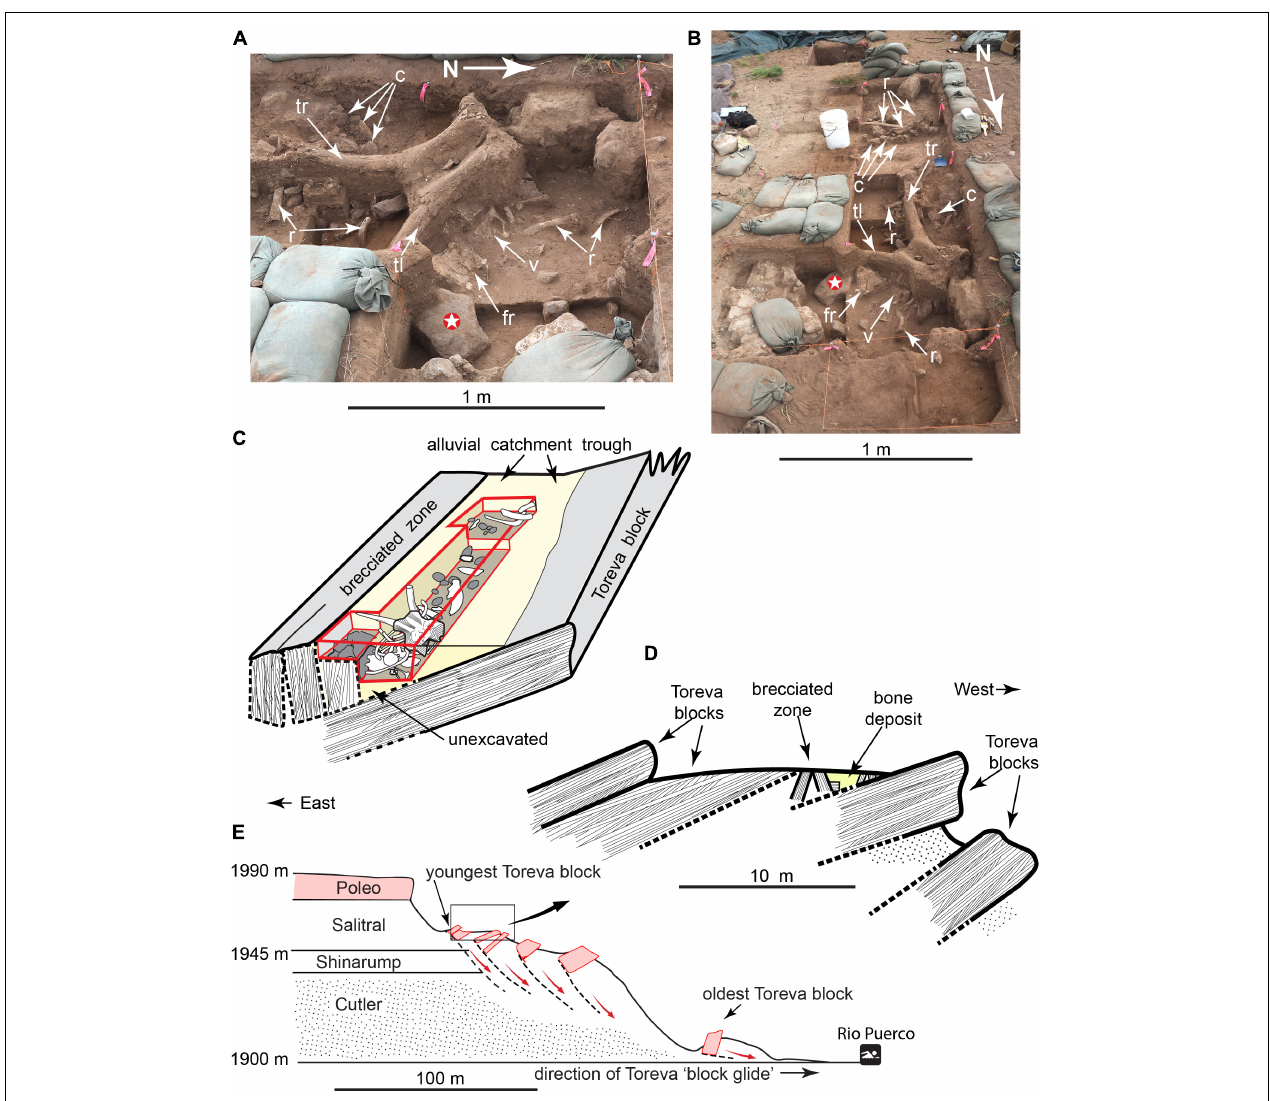
FIGURE 1 | Hartley mammoth excavation. (A,B) Uppermost part of main bone accumulation. (C) Diagram of bone-bearing sediment wedge (not to scale). (D) Schematic of Toreva block landslides. (E) Cross-section of Rio Puerco canyon. C, sandstone cobbles; R, rib; Tl, left tusk; Tr, right tusk; Fr, frontal; V, thoracic vertebra; white star, 23.7 kg